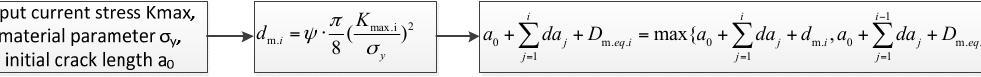
Figure 19. The calculation of the equivalent plastic zone.